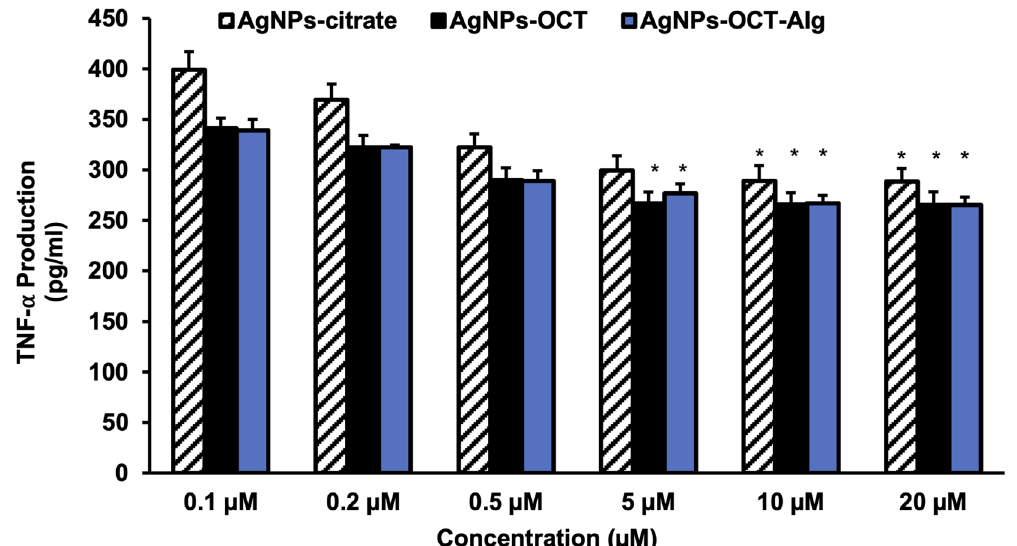
Figure 5: Production of TNF - α after treatment with AgNP formulations in MCF - 7 cells. The results are representative ( mean ± standard error of the mean ) of triplicate experiments. Data without an asterisk di ff er and concentrations of 5 – 10 µM showed signi fi cant TNF - α inhibition ( p < 0.05 ) . * p < 0.05 versus untreated cells ( control cells )